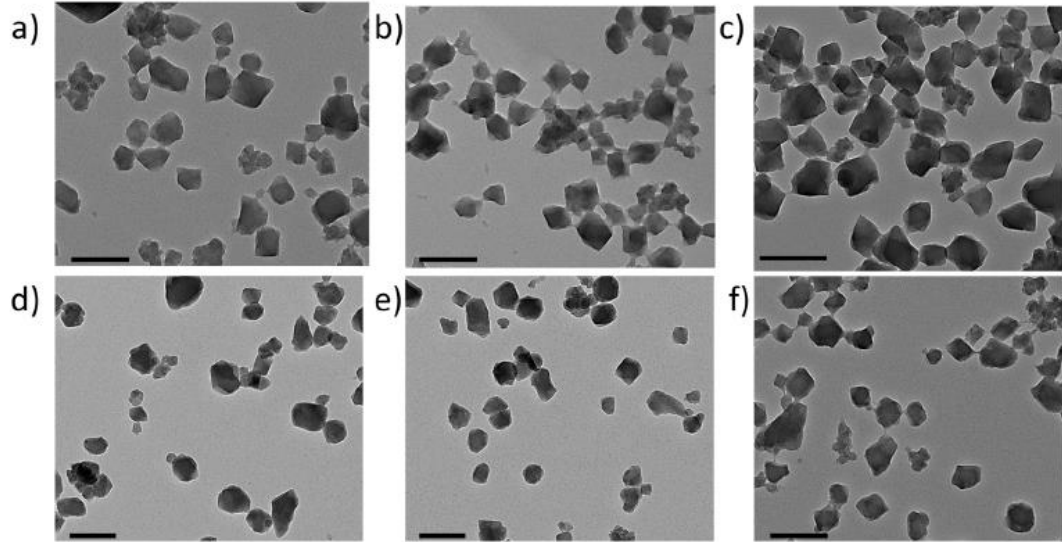
Figure 2. TEM images of MIL-100(Fe) before and after modification with β -CDs derivatives: ( a ) unmodified MIL-100(Fe); ( b ) β -CD phosphate sodium salt purchased [27] modified MIL-100(Fe); ( c ) H9 modified MIL-100(Fe); ( d ) H10 modified MIL-100(Fe); ( e ) H11 modified MIL-100(Fe); ( f ) H12 modified MIL-100(Fe). Scale bar = 200 nm. These pictures indicate that after the introduction of CDs, the obtained organic–inorganic hybrid materials kept similar sizes and the rigid architectures were not affected. Reproduced from Reference [27] with permission from MDPI, copyright 2019.